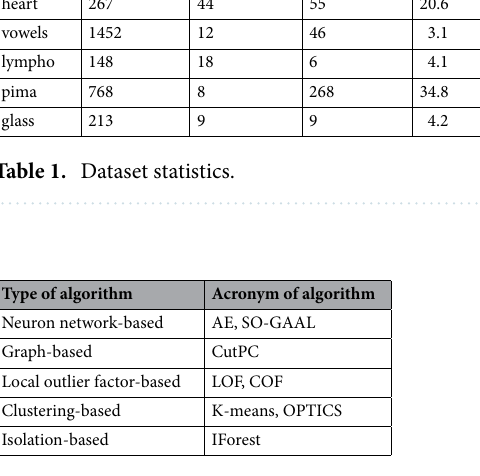
Table 2. Comparison algorithm statistics.